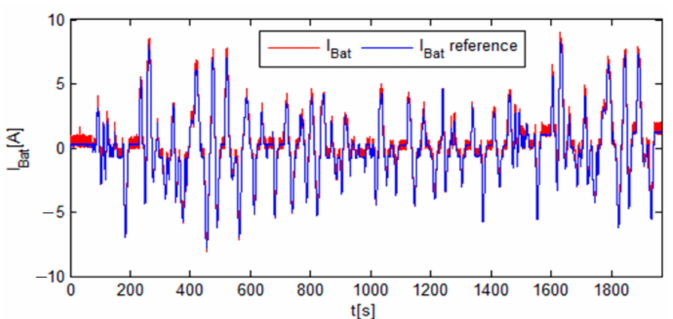
Figure 29. Battery current control result.